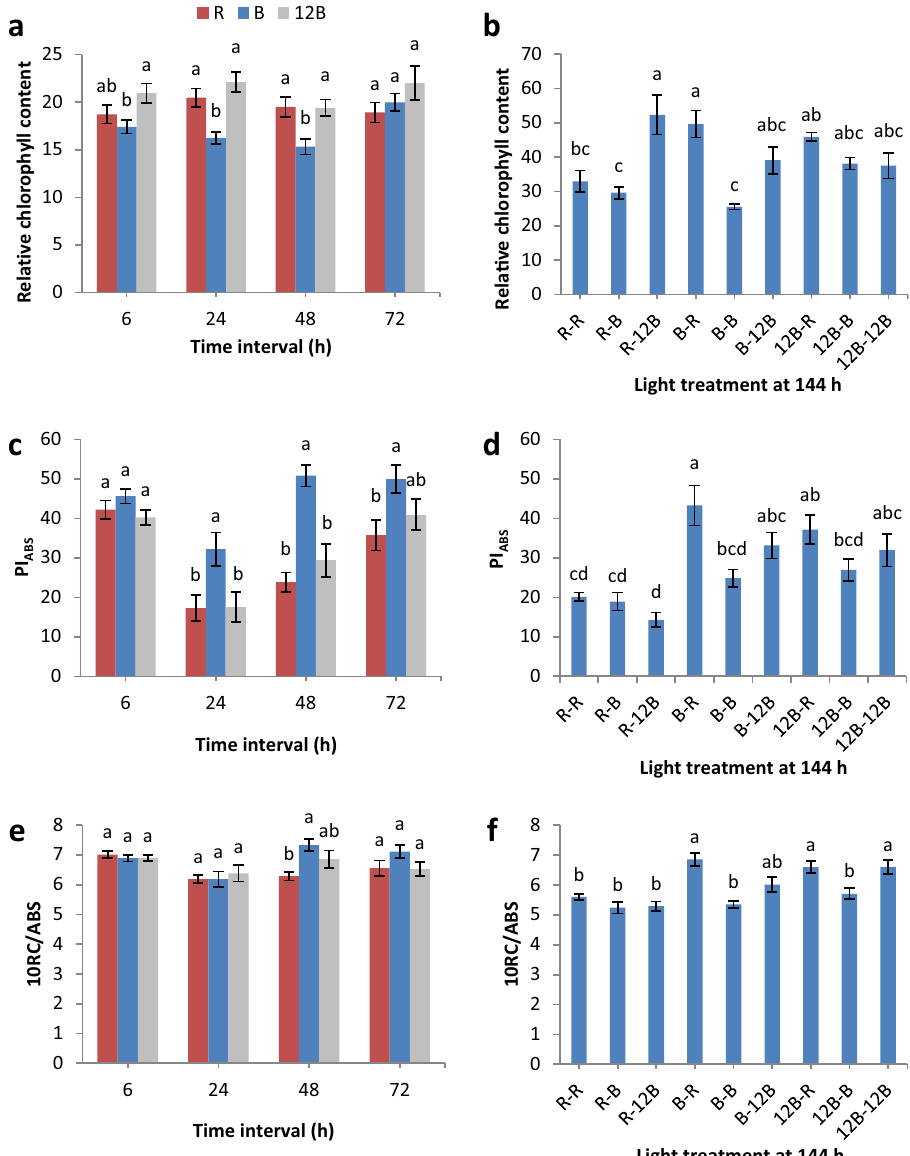
Figure 1. Relative chlorophyll content ( a , b ), performance index on absorption basis (PI ABS ) ( c , d ), and density of active reaction centres (10RC/ABS) ( e , f ) of grafted watermelon seedlings at four time intervals under three light treatments ( a , c , e ) and at day 6 (144 h) under nine light treatments ( b , d , f ) in the healing chamber. Bars (± SE) within a time interval followed by different letters are significantly different (a < 0.05). Mean values derived from n = 10